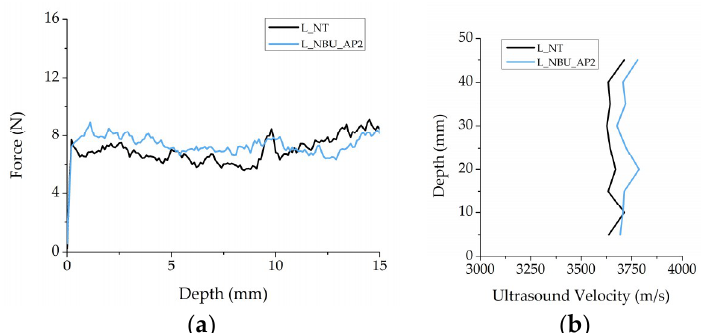
Figure 9. Lecce stone treated with NBU applied through absorption by capillarity AP2 (L_NBU_AP2): ( a ) drilling resistance and ( b ) UPV profile. NT: untreated stone.